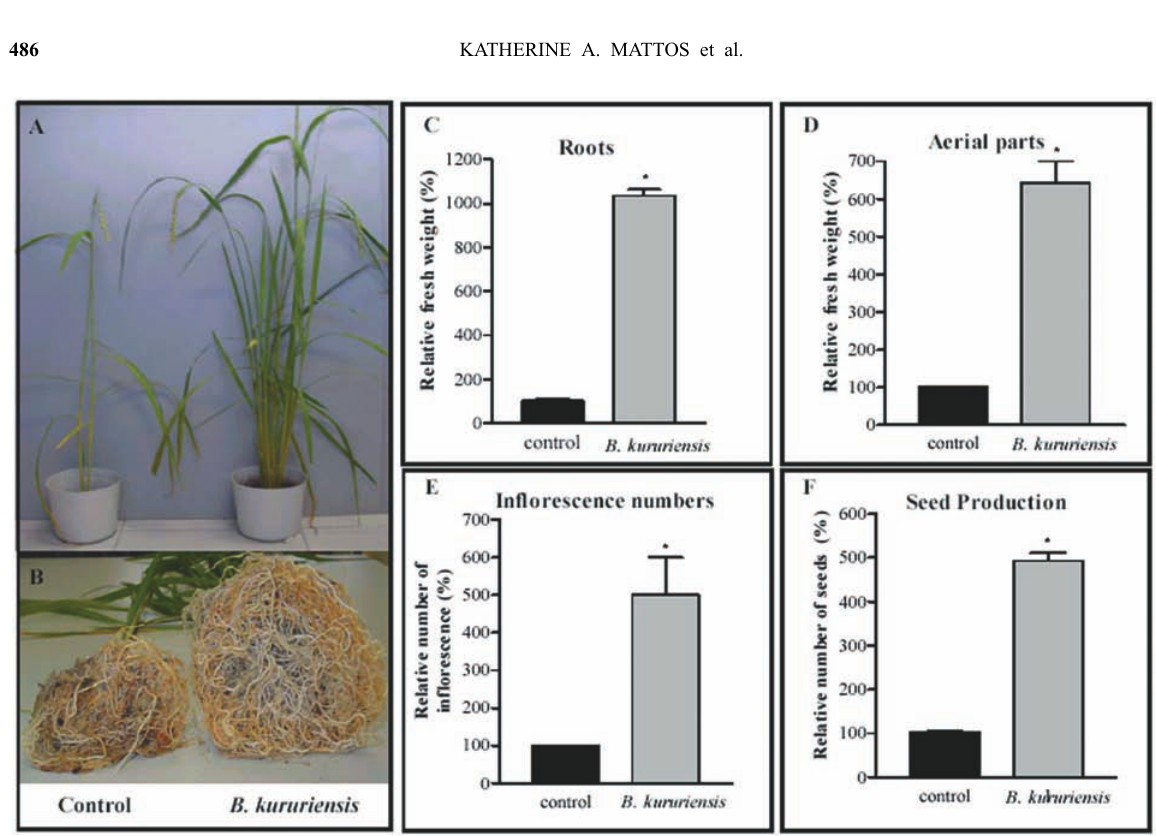
Fig. 4 – Enhanced rice development promoted by B. kururiensis association. Picture shows a comparative view of inoculated and non-inoculated plants at 120 dpi. ( A ) Aerial parts showing extensive differentiation. ( B ) Root system showing significant difference in weight and thickness. ( C ) Percentages of relative fresh weight of root systems and ( D ) aerial parts. ( E ) Percentage of relative flowering numbers, and seed production ( F ). Bars represent means, and error bars indicate standard